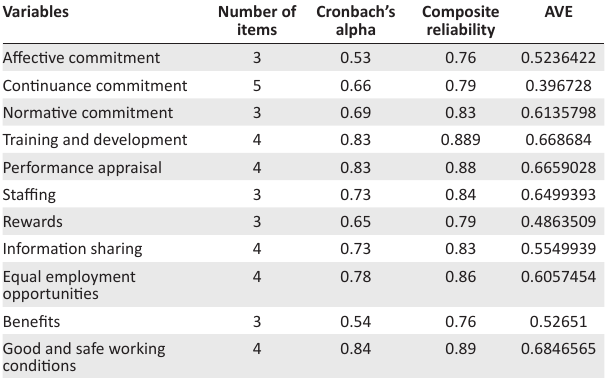
TABLE 2: Final model: Revised assessment of the internal consistency.